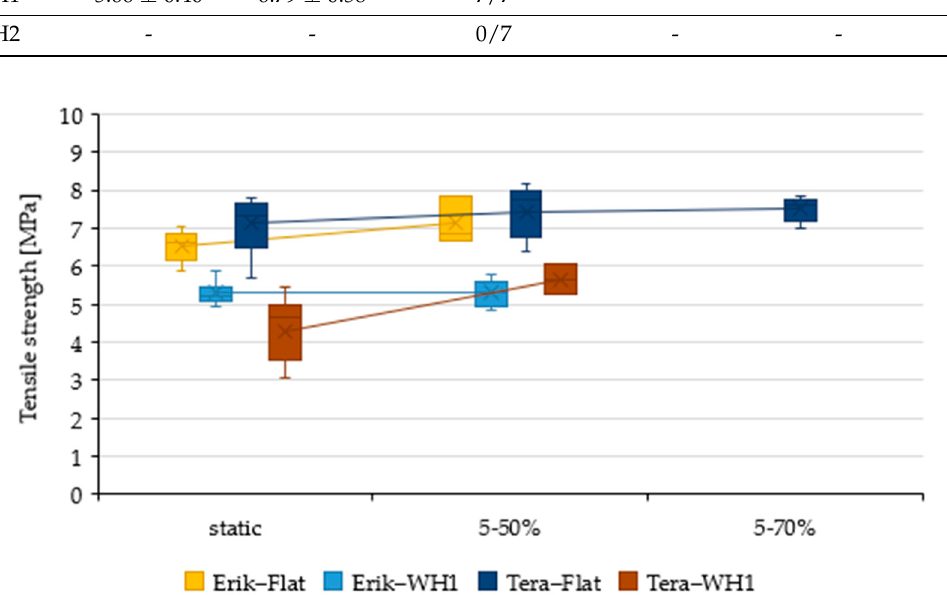
Figure 6. Evaluation of the tensile strength of the adhesive bonds under static loading and cyclic loading in the load intervals 5–50% and 5–70%.